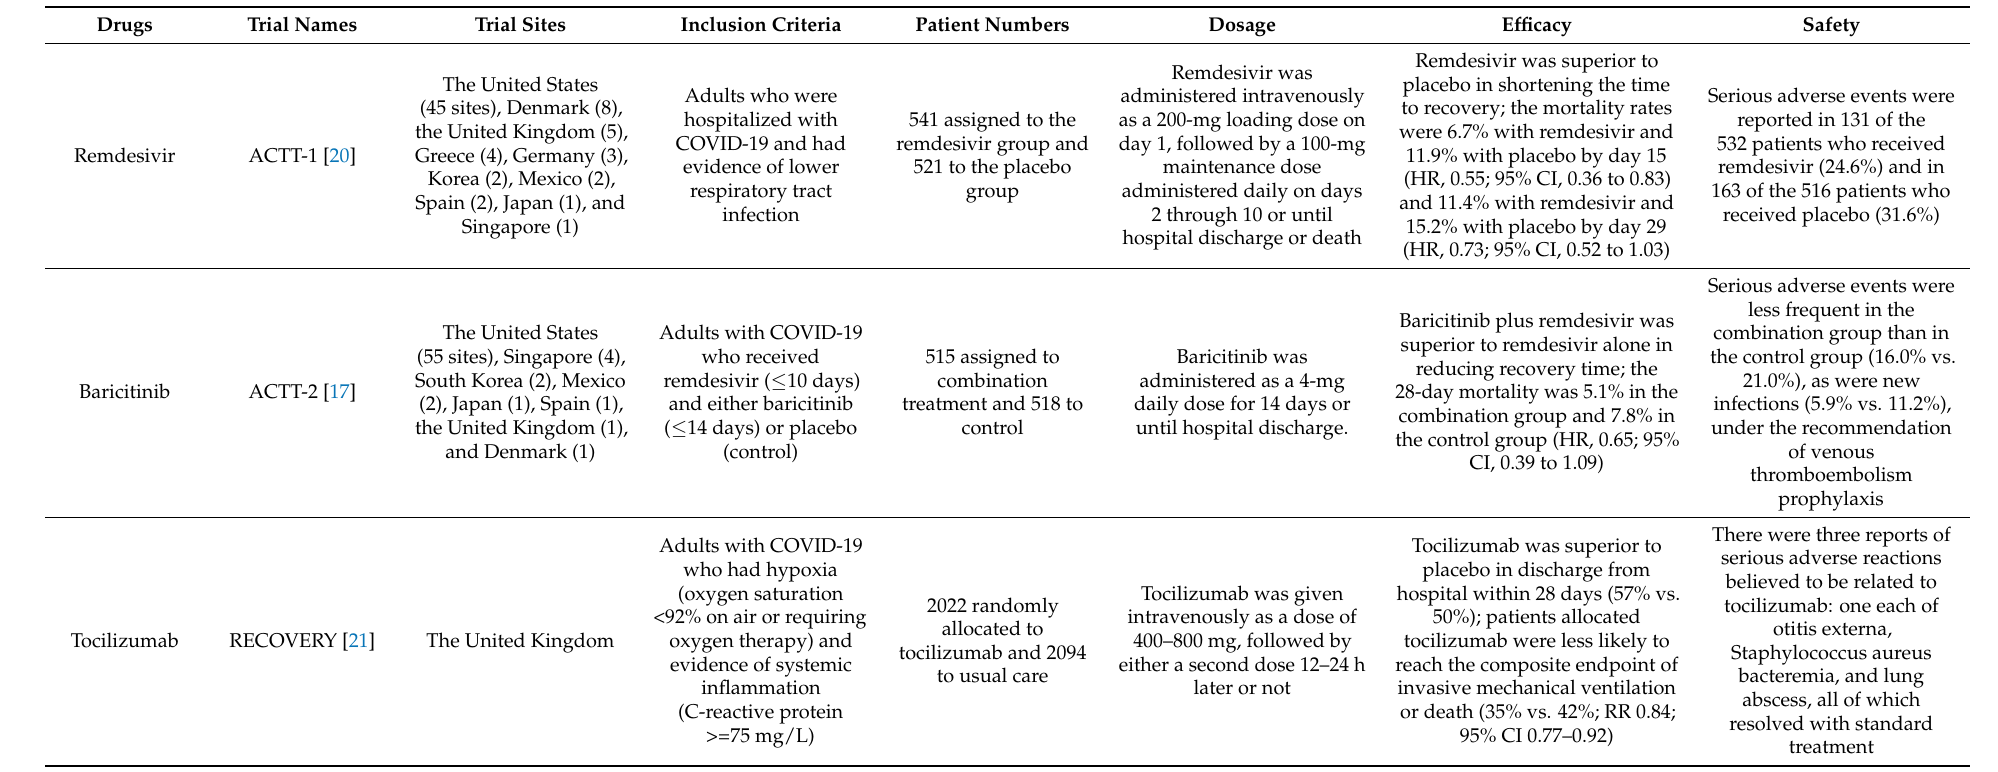
Table 2. The completed and ongoing randomized controlled trials of available drugs in moderate-to-severe